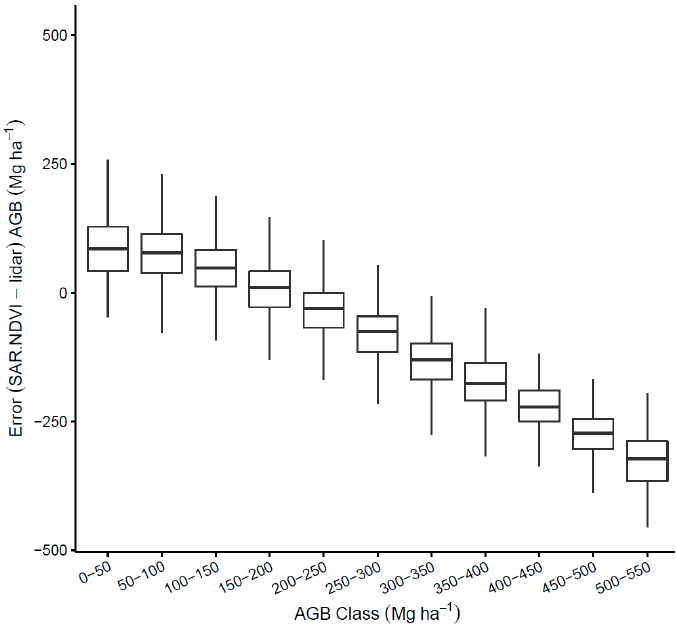
Figure 6. Distribution of AGB values in SAR plus NDVI and lidar-based maps. Boxes represent upper (75%) and lower (25%) quartiles; vertical segments out of boxes are minimum and maximum values; boxes are divided by the median; diamonds represent the mean. Remote Sens. 2017 , 9 , 18